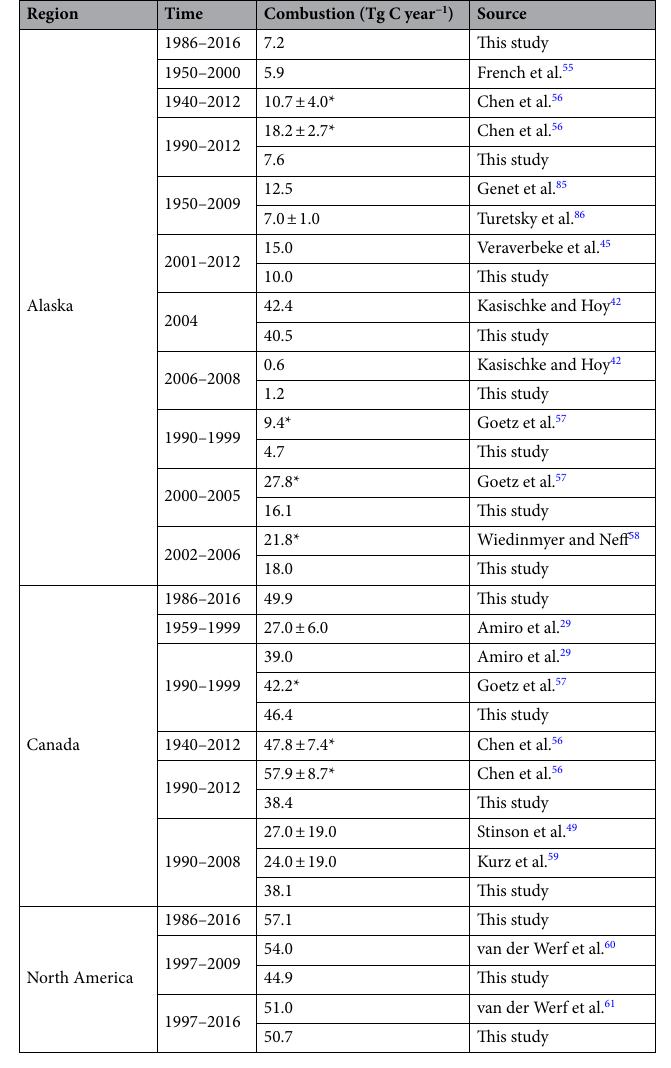
Table 1. Comparison on regional combustion emission per year (*shows the estimation for entire Alaska/